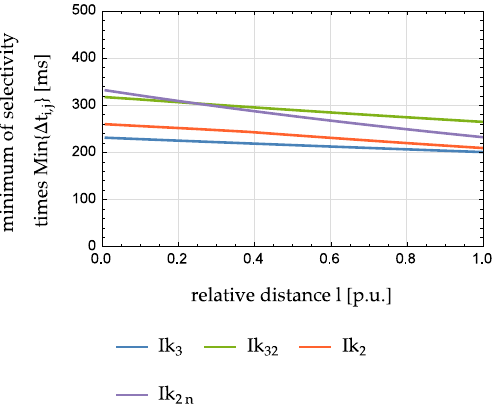
Figure 14. Dependence of the minimum selectivity times Min { ∆ tm i,j } on relative distance l for radial power system where only three-phase-to-earth short-circuits are considered.